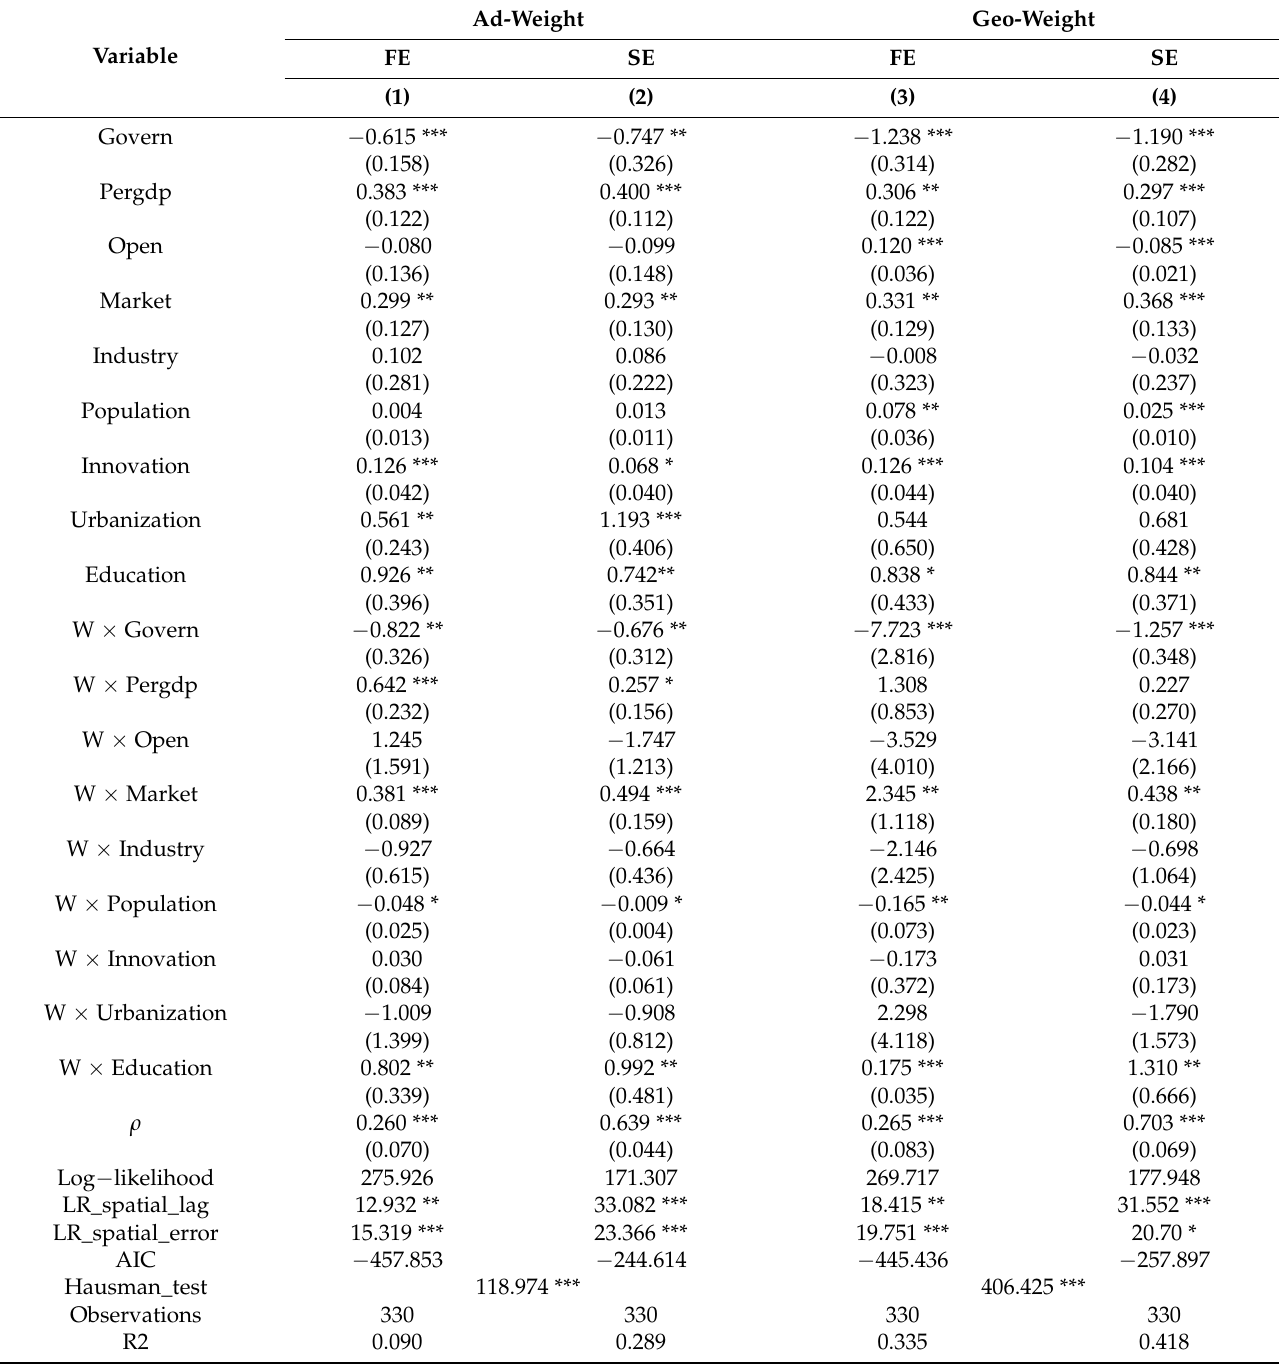
Table 5. Estimation results of SDM